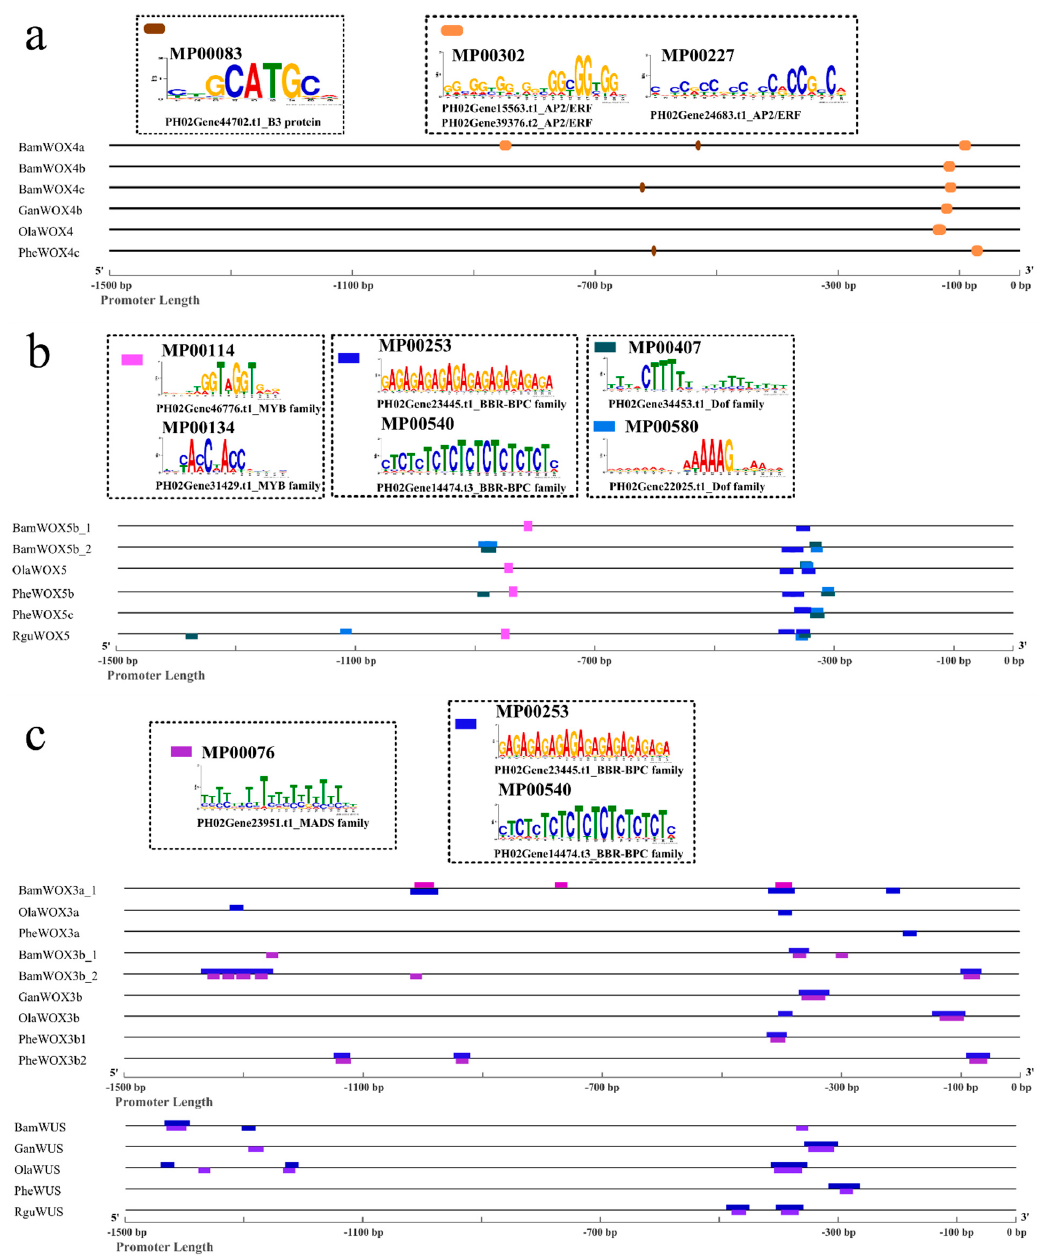
Figure 7. The conserved cis-element distribution in the promoters of Bambusoideae WOX4 ( a ), WOX5 ( b ), and WOX3 and WUS ( c ). The 1500-bp-long promoters were analyzed by PlantRegMap. The ID of the cis-elements was in accordance with the transcription factor (TF) binding motif dataset of PlantTFDB and is shown with di ff erent colored rectangles. The TFs were predicted by comparing homologous genes with TF datasets of Arabidopsis (http://planttfdb.cbi.pku.edu.cn/index.php?sp=Ath).